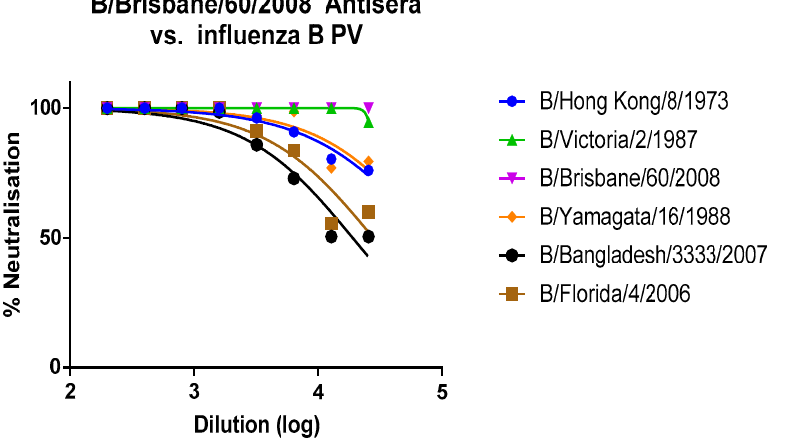
Figure 1. Anti-B/Brisbane/60/2008 HA serum (11/136, NIBSC) neutralises matched and related strains B/Brisbane/60/2008 and B/Victoria/2/1987 the strongest but also neutralises Yamagata lineage strains and the B/Hong Kong/7/1973 precursor to a lesser extent.